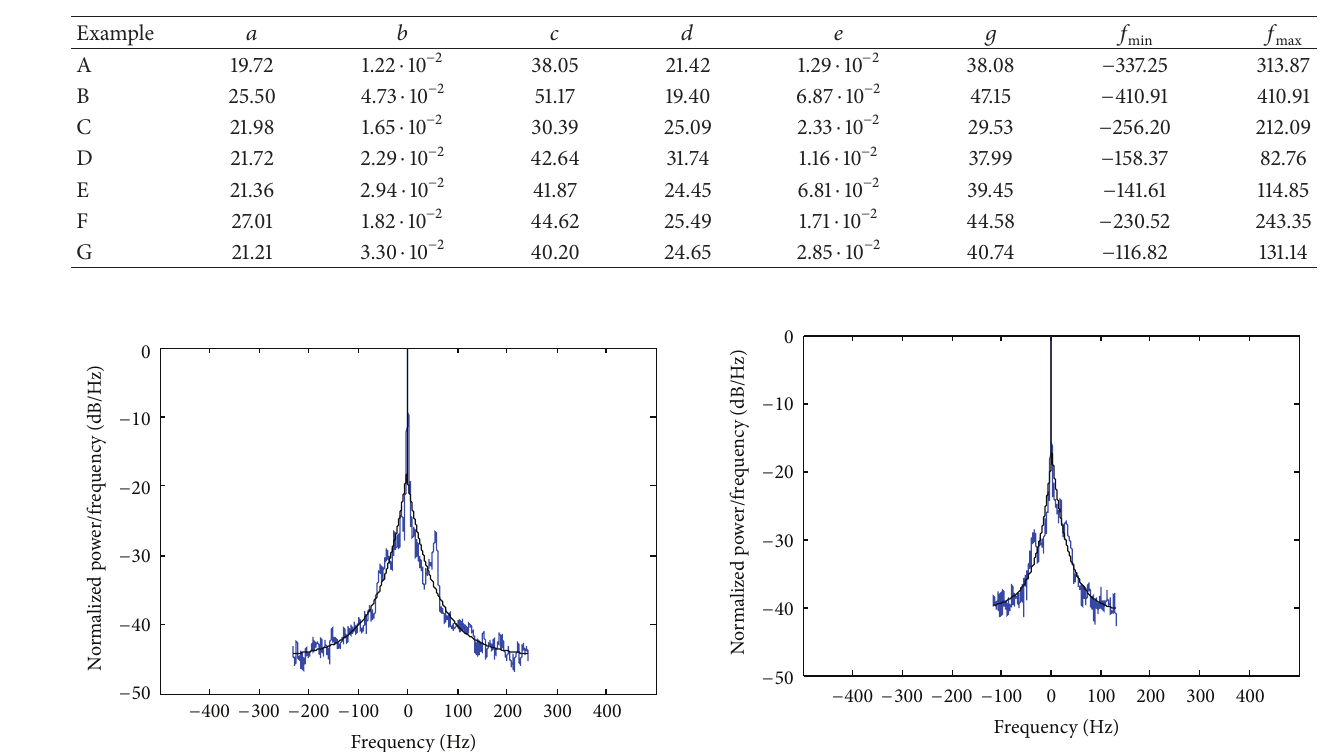
Table 4: Fitting parameters of the representative Doppler spectra.